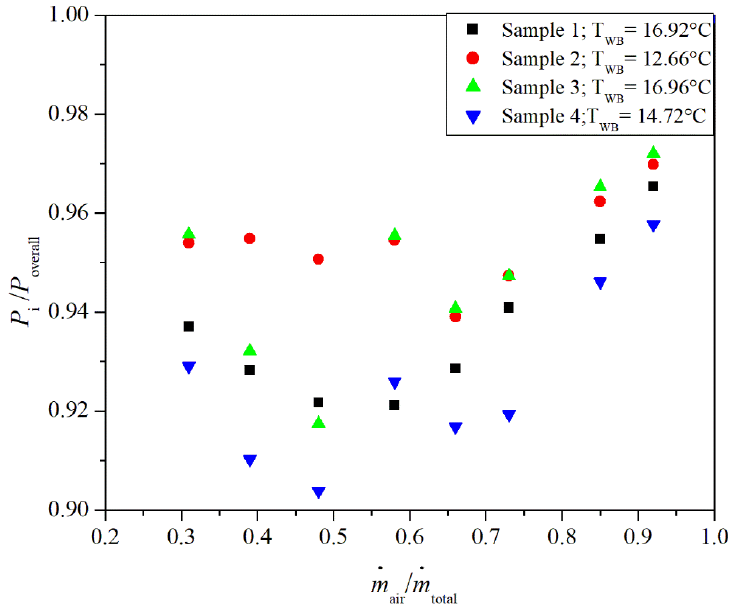
Figure 6. Variation of electrical power of the fans’ motors of the evaporative condenser as a function of mass flow rate of air. Table 3. Overall compressor and condenser electrical power demands.